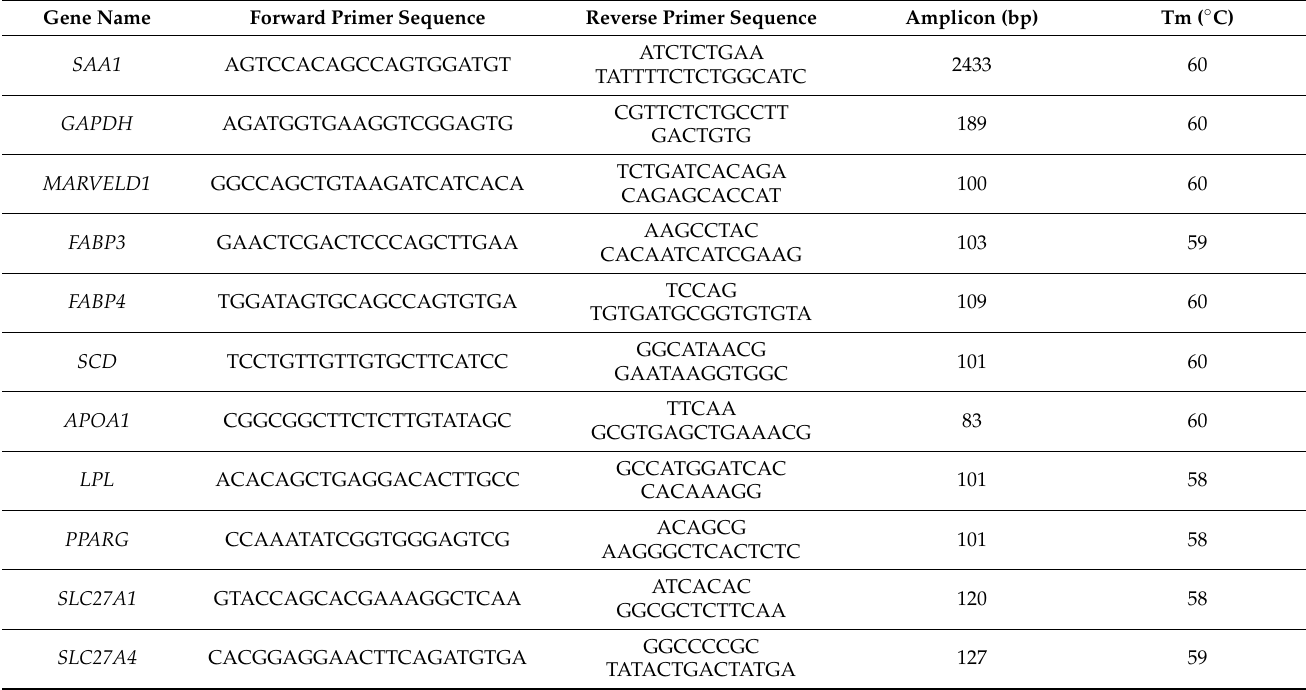
Table 2. Primer sequences used for